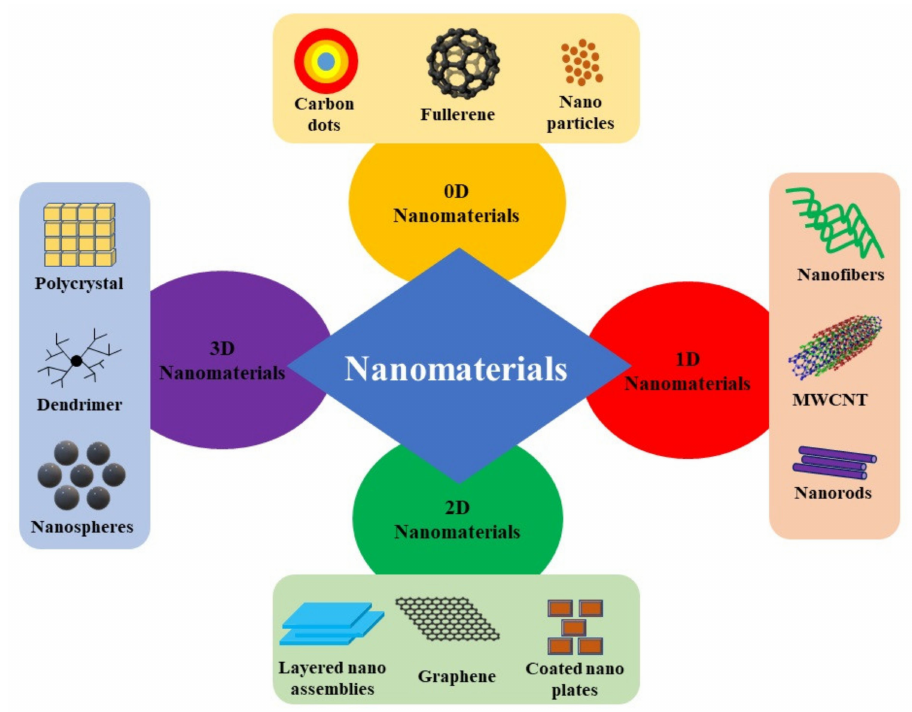
Figure 1. Classification of nanomaterials according to their confined